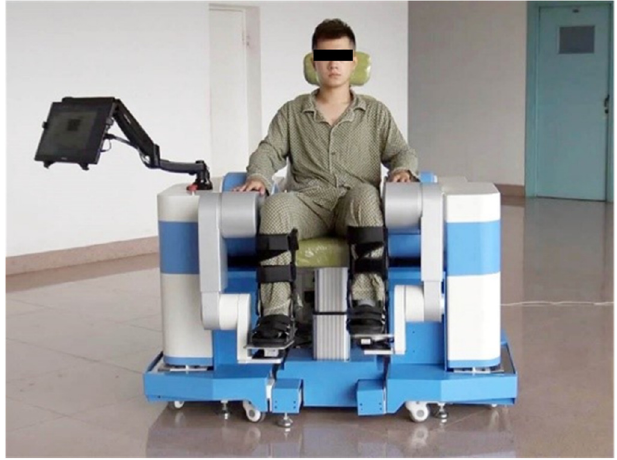
Figure 1. LLR-II consists of two symmetrical training modules (the right one includes a touch display screen and an emergency stop button), a seat module (which can adjust high and back), and an electric control cabinet (behind the seat). Each part of LLR-II can be assembled together by linking their underframes. The width between two training modules can be adjusted, and the moveable seat can move out and transfer users to the training position.